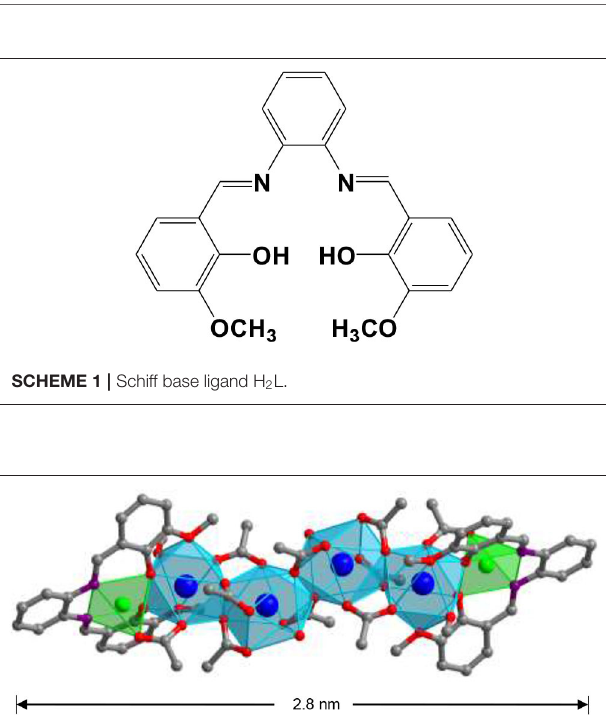
1 has nanoscale rectangular structure with diameters of 0.8